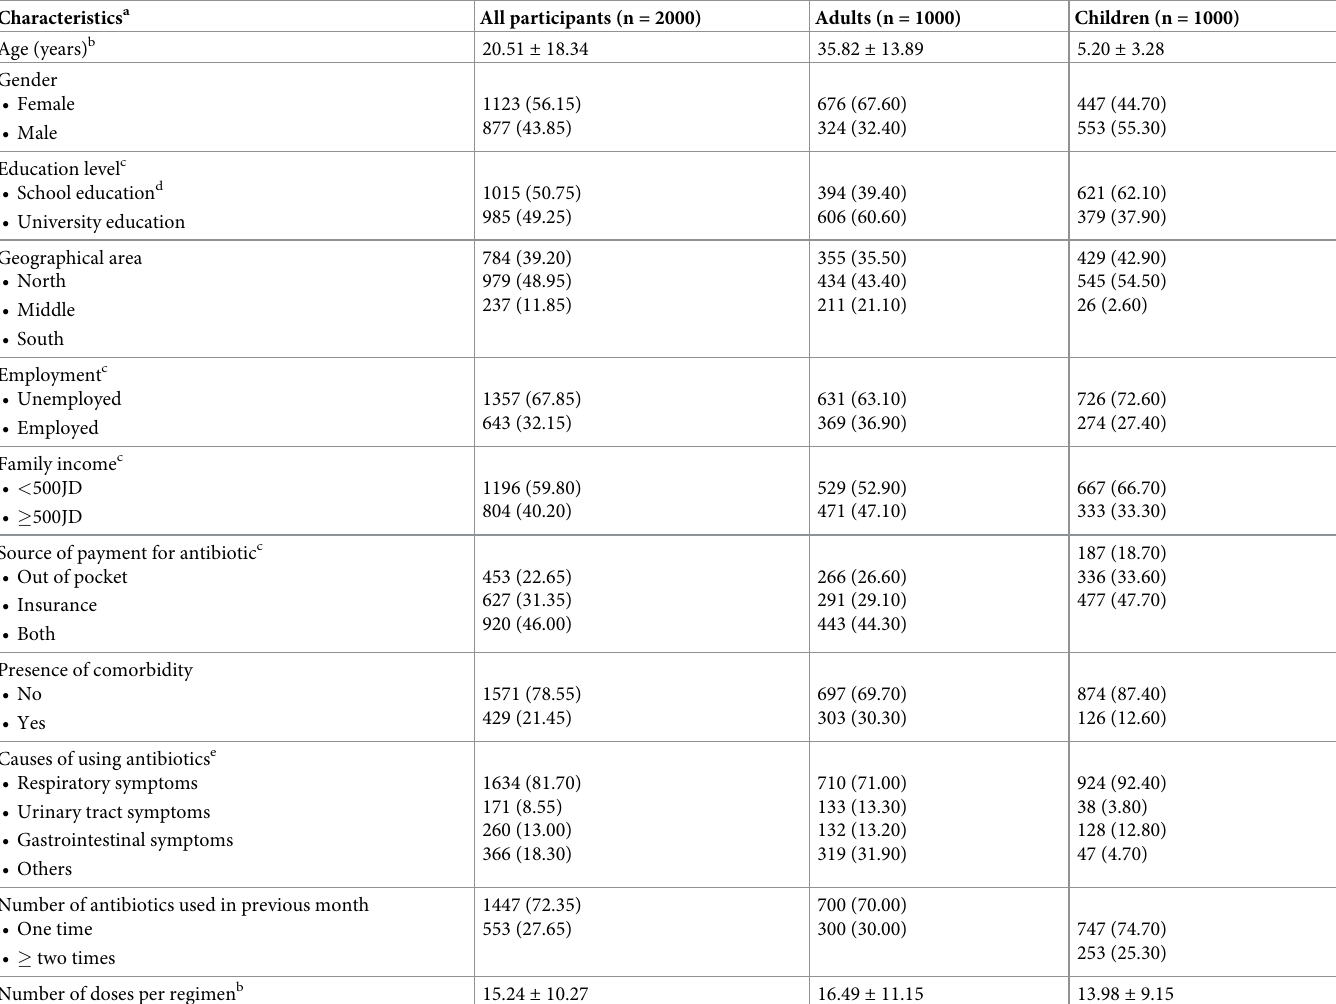
Table 1. Demographic and clinical